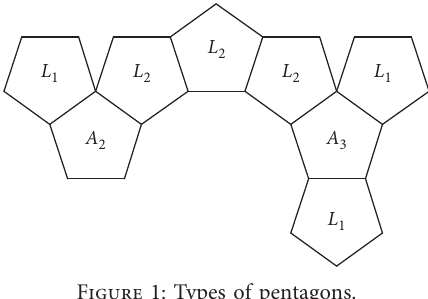
Figure 1: Types of